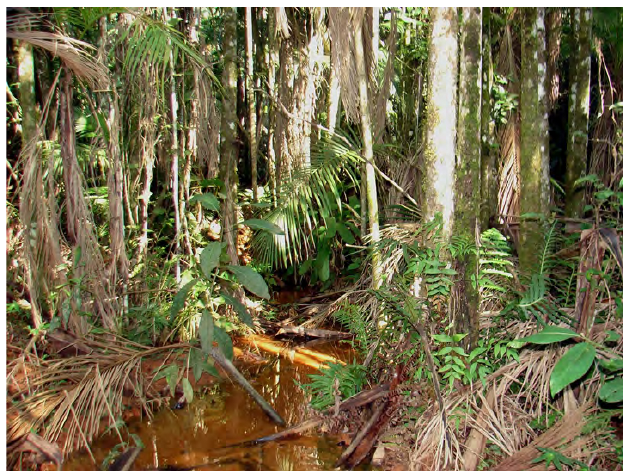
Figure 3. Calling site in forest fragment presenting dense leaf litter Euterpe edulis layer, saturated soil and stagnant pools, with the presence of palm trees (